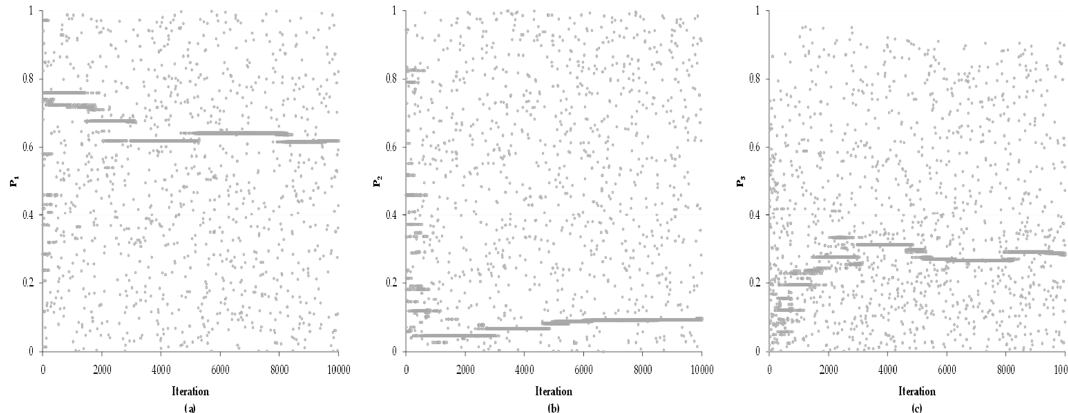
Figure 6. Behavior of the probability parameter for the EV1-3P with respect to the iterations of ( a ) P 1 ; ( b ) P 2 ; and ( c ) P 3 for hydrometric station 10040.